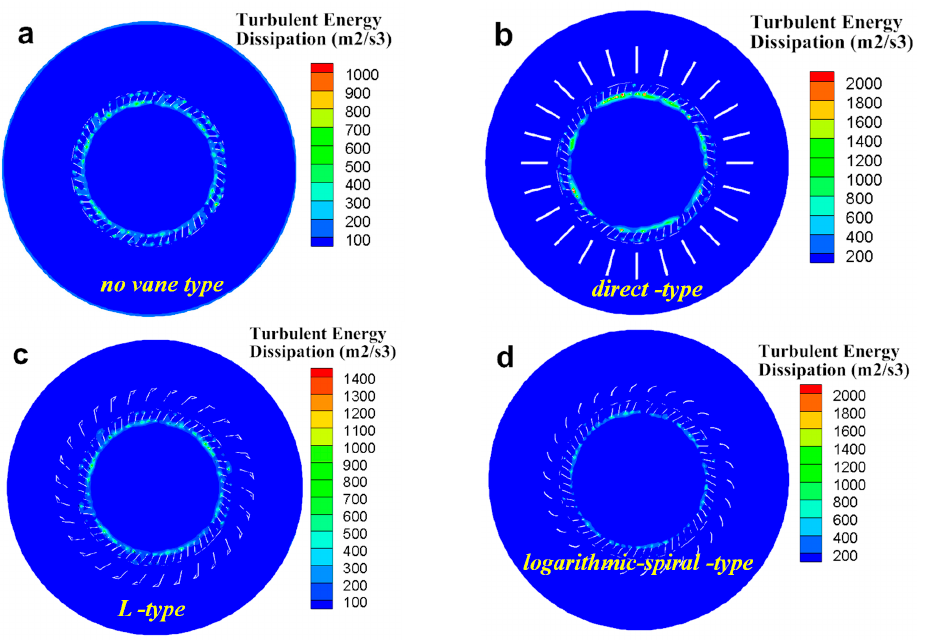
Figure 11. Comparison of the turbulent energy dissipation of rotor cage by four different guide vanes in (Z = 0 m) section. ( a ) no vane type; ( b ) direct-type; ( c ) no vane type; ( d ) direct-type.